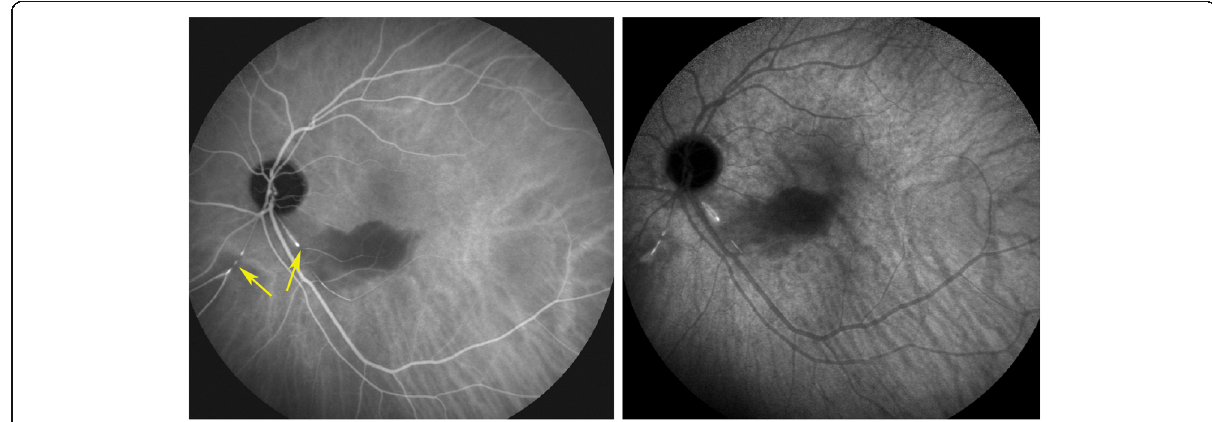
Fig. 6 Indocyanine green angiography. Same view of fundus as on Fig. 5, showing precisely arterial stop and/or interruption (arrows) (case